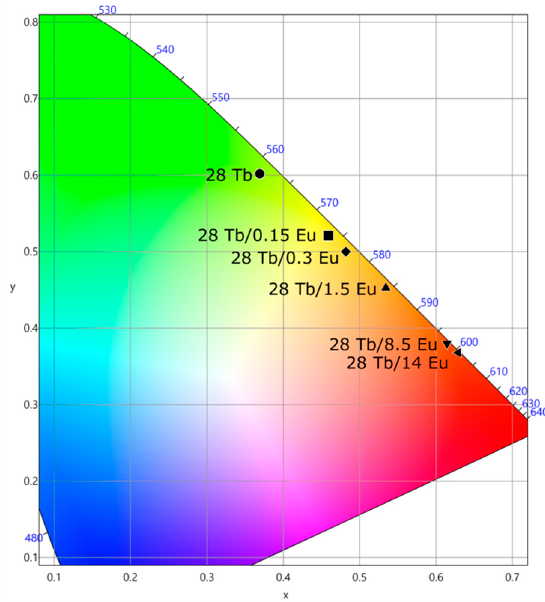
Figure 11. CIE diagram of chromaticity as function of Eu 3+ content.